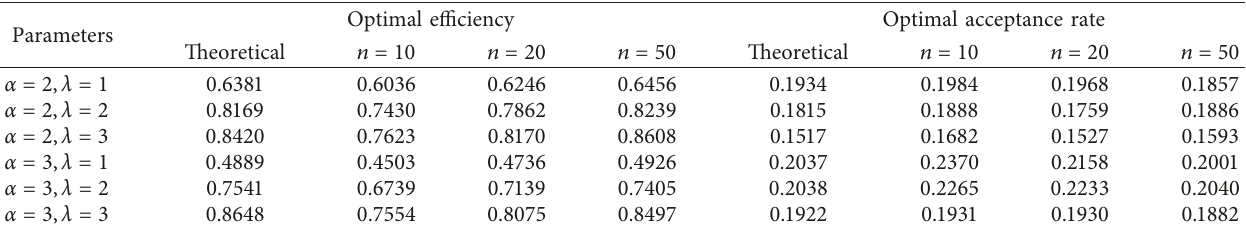
Figure 1: Efficiency of RWM algorithm against acceptance rate for the normal-normal hierarchical target. (a) Efficiency of X set of curves corresponds to homogeneous proposal variances. (b) Efficiency of all n components; the top set of curves now corresponds to inhomogeneous proposal variances. Table 1: Optimal efficiency and acceptance rate of chains in various dimension ( n � 10, 20, and 50) for different parameters α and λ of the . The theoretical optimal efficiency and acceptance rate are also included for comparison. gamma distribution for X 1